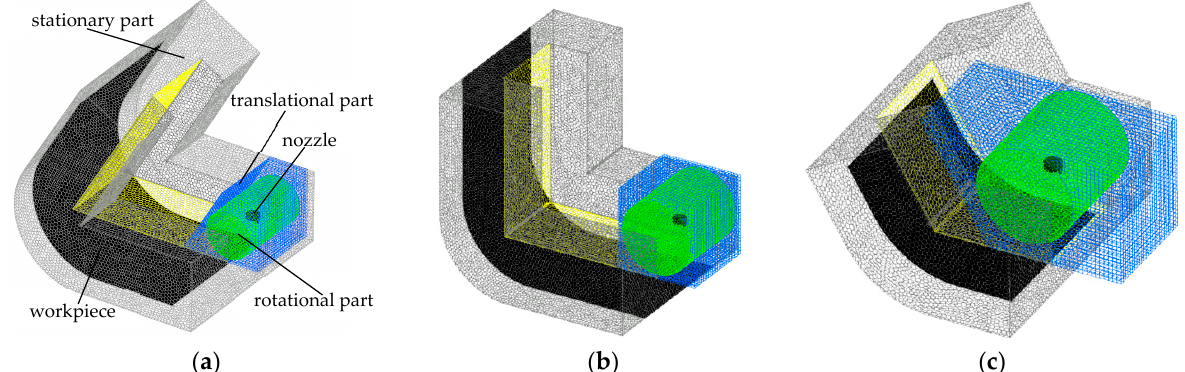
Figure 3. Computational domains for arc connecting surfaces: ( a ) 60 degrees; ( b ) 90 degrees; ( c ) 120 degrees.